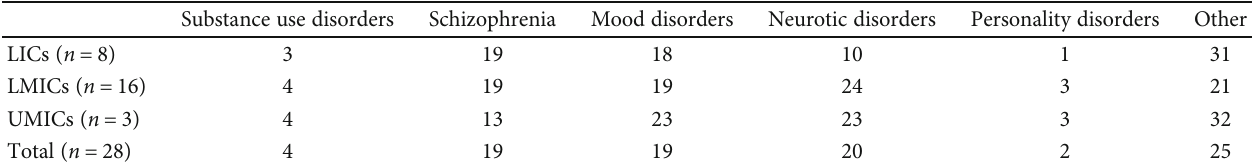
Table 4: WHO-AIMS report, percentage of disorders treated in mental health facilities, by country income group (median